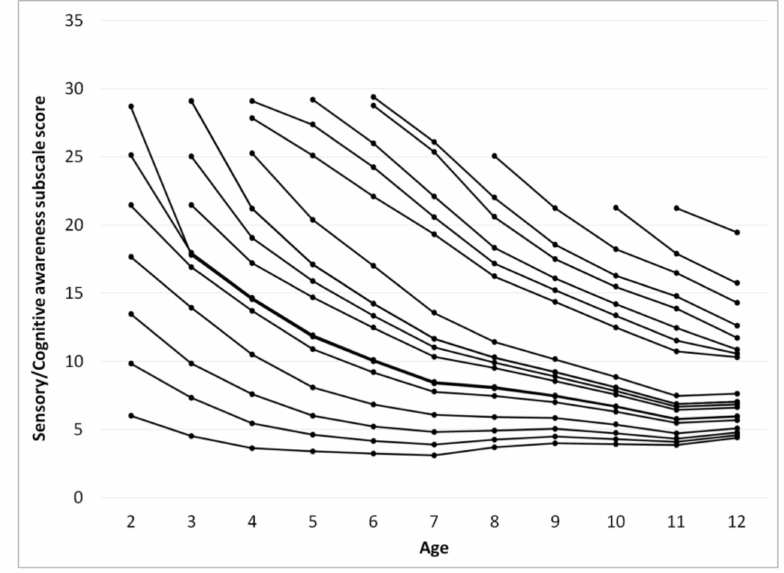
Figure 5. Continuous changes of the Sensory/Cognitive awareness subscale score over age calculated from pair-wise observations using the “relay”